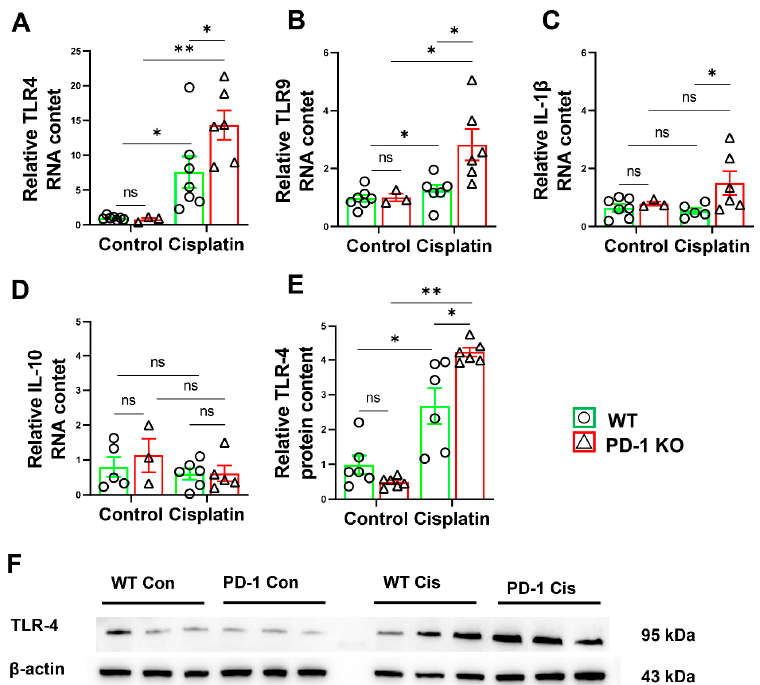
Figure 5. PD-1 − / − exacerbated muscle inflammation in mice after cisplatin treatment. ( A ) The relative mRNA levels of TLR4 in skeletal muscle. ( B ) The relative mRNA levels of TLR9 in skeletal muscle. ( C ) The relative mRNA levels of IL-1 β in skeletal muscle. ( D ) The relative mRNA levels of IL-10 in skeletal muscle. ( E ) The relative protein levels of TLR4 in skeletal muscle. ( F ) The representative protein bands of TLR4 and β -actin in skeletal muscle. mRNAs were normalized to GAPDH. Proteins were normalized to β -actin. n = 5–6 per group. * p < 0.05; ** p < 0.01; ns: non-significant. all values are mean ± SEM.